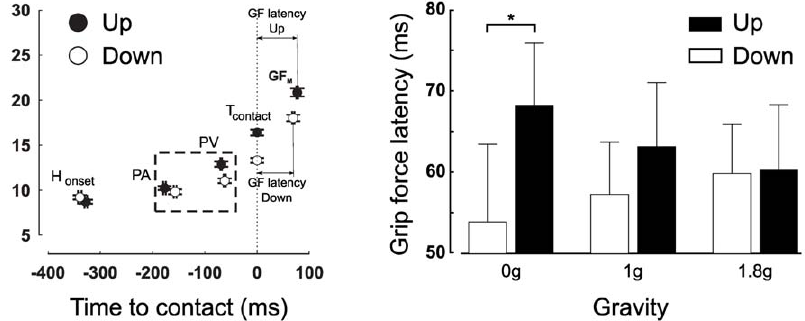
Figure 3. Grip force adjustment over time. (Left) Grip force in function of time to contact in upward (closed disks) and downward (open disks) movements in 0 g. The means and SE of grip forces are reported for the following occurrences: hand onset (H onset ), peak acceleration (PA), peak velocity (PV), time of contact (T contact ) and grip force maximum (GF M ). The horizontal SEs quantify the variability in the occurrences of these events. The vertical dotted line is positioned at contact. (Right) Delay between peak grip forces and contact in upward (black bars) and downward (open bars) trials in 0 g, 1 g and 1.8 g. All values are positive which means that peak grip forces lag the collision. Error bars are between participants SD. Asterisk denotes significant difference (p , 0.05).